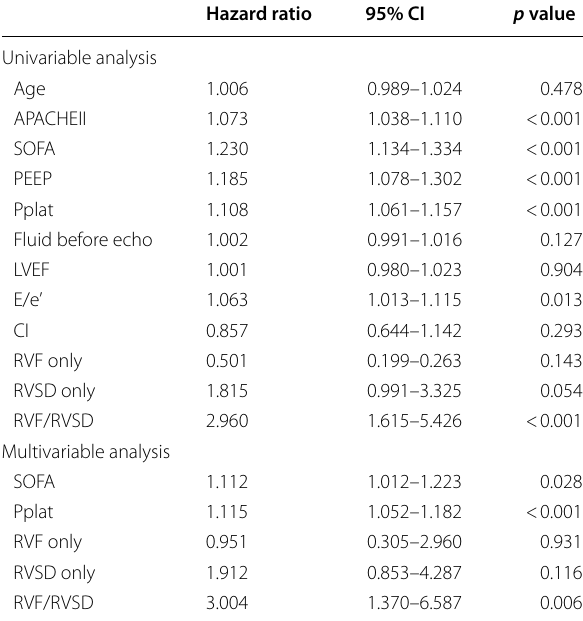
Table 3 Factors associated with 30-day mortality with sensitivity